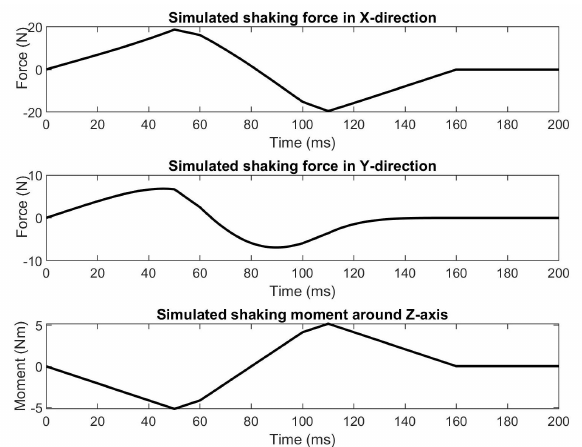
Figure 13. Simulated shaking forces and shaking moment of the prototype unbalanced manipulator arm for the motion in Figure 7. The peak shaking force is 25.54 N and the peak shaking moment is 5.16 Nm.